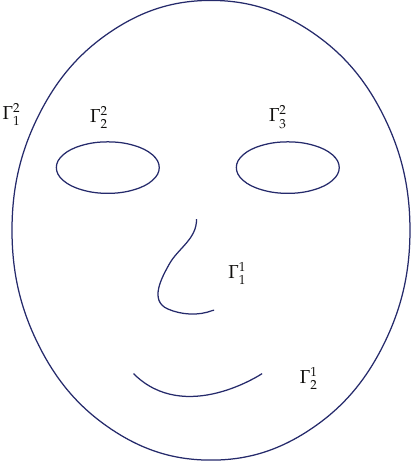
Figure 1: An example of an interior domain.